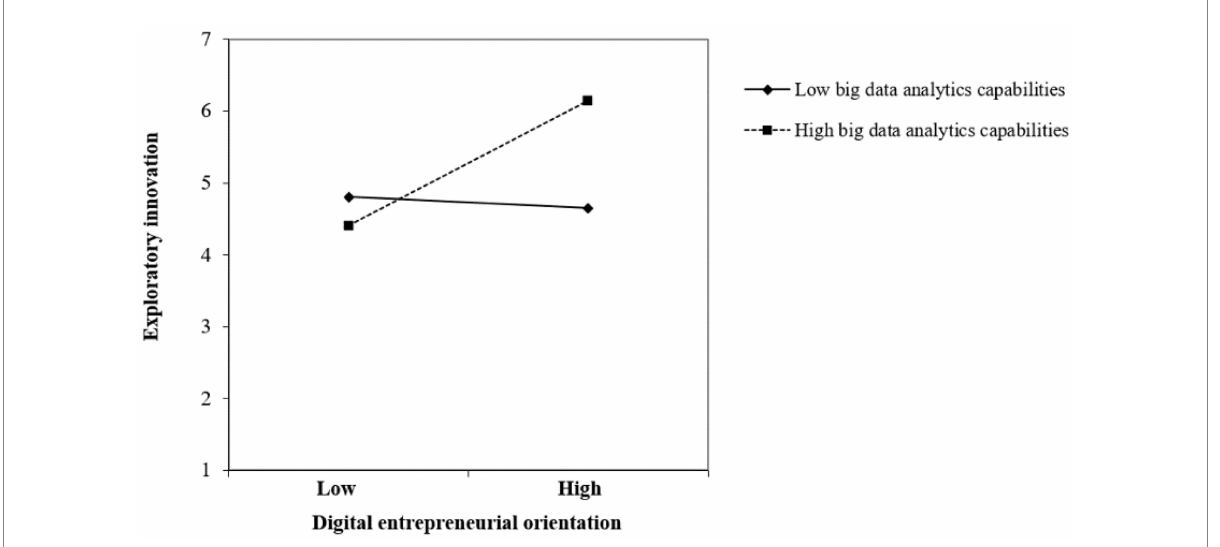
FIGURE 3 The moderating effect of big data analytic capabilities on the relationship between digital entrepreneurship orientation and exploratory